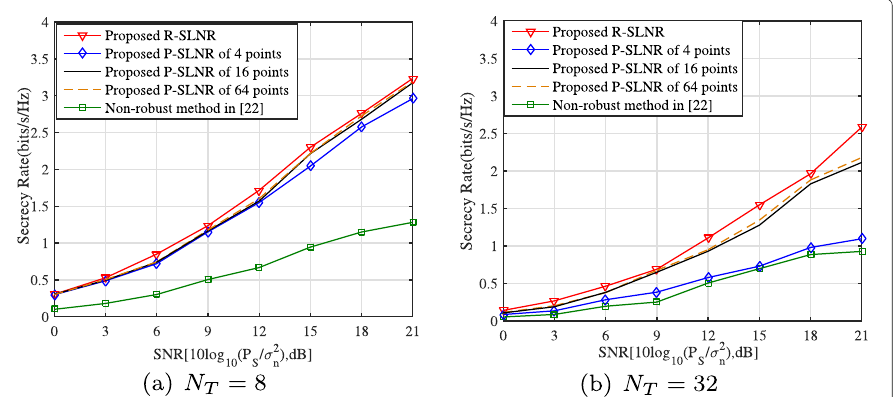
Fig. 6 The curves of secrecy rate versus SNR(10 log 10 ( P /σ 2 n ) ) of the proposed methods with N T = 8